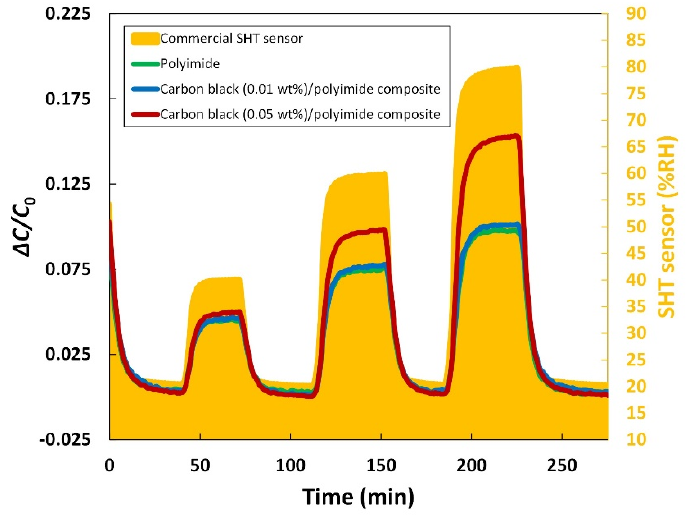
Figure 6. Dynamic response of the humidity sensors.